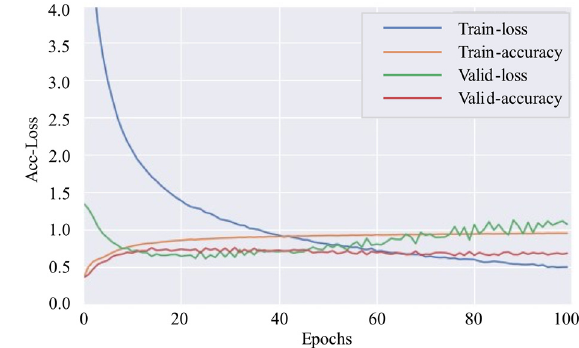
Figure 20. Learning curve (1D-CNN).